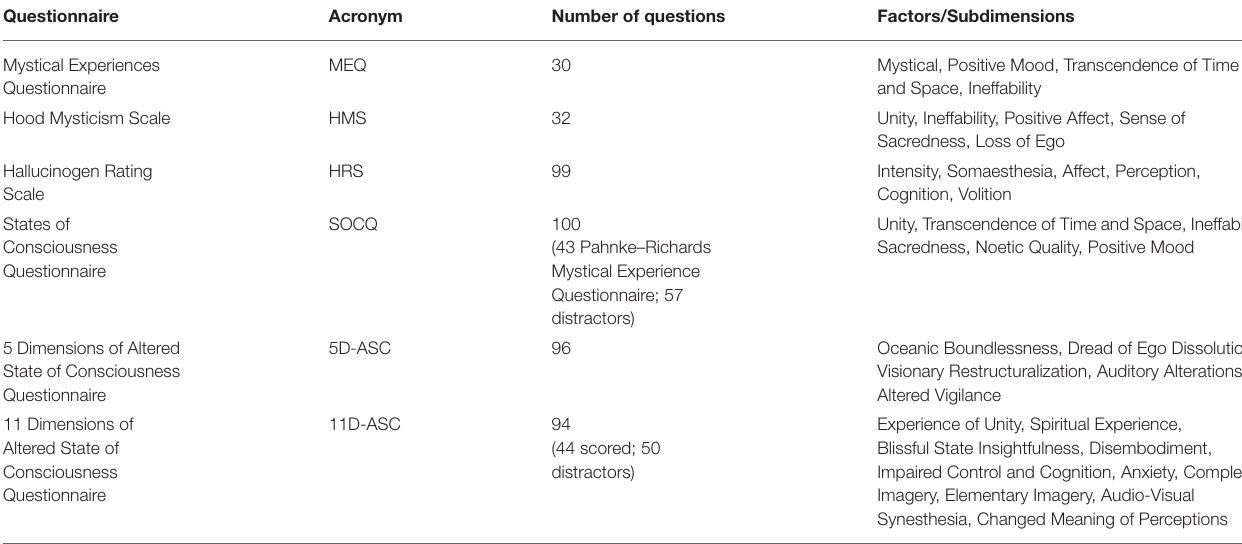
TABLE 1 | Instruments